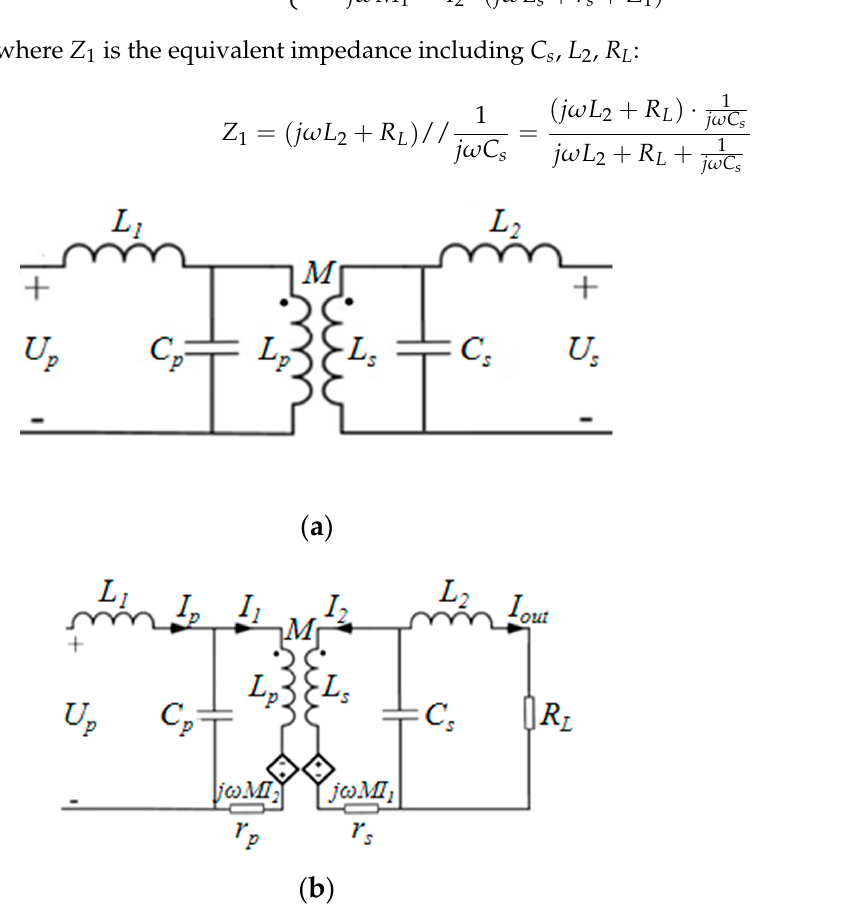
Figure 10. Dual-LCL compensation model and equivalent circuit: ( a ) dual-LCL compensation model, ( b ) dual-LCL equivalent circuit.